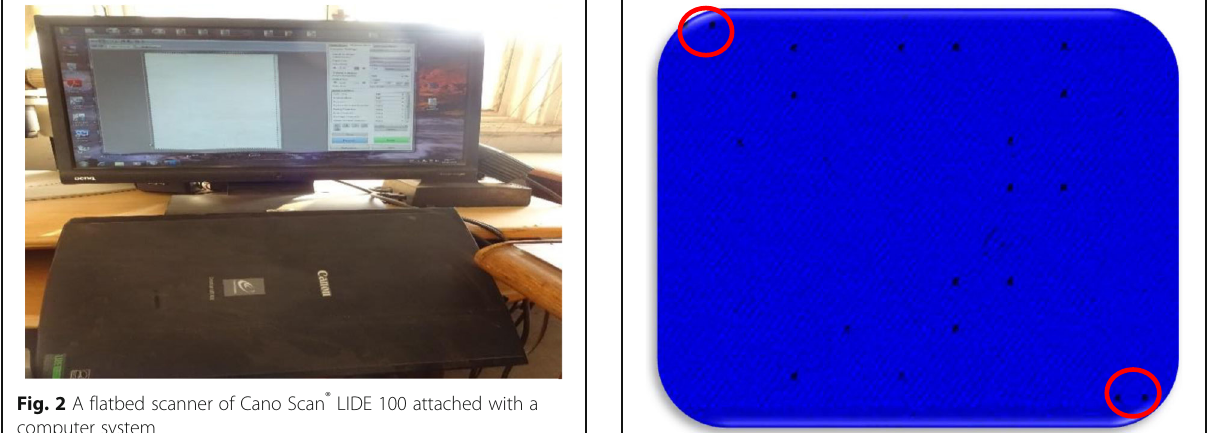
Fig. 4 The RGB mode of the regular repeated basic coded dot matrix model in black color of Ricoh ® MP C 4500